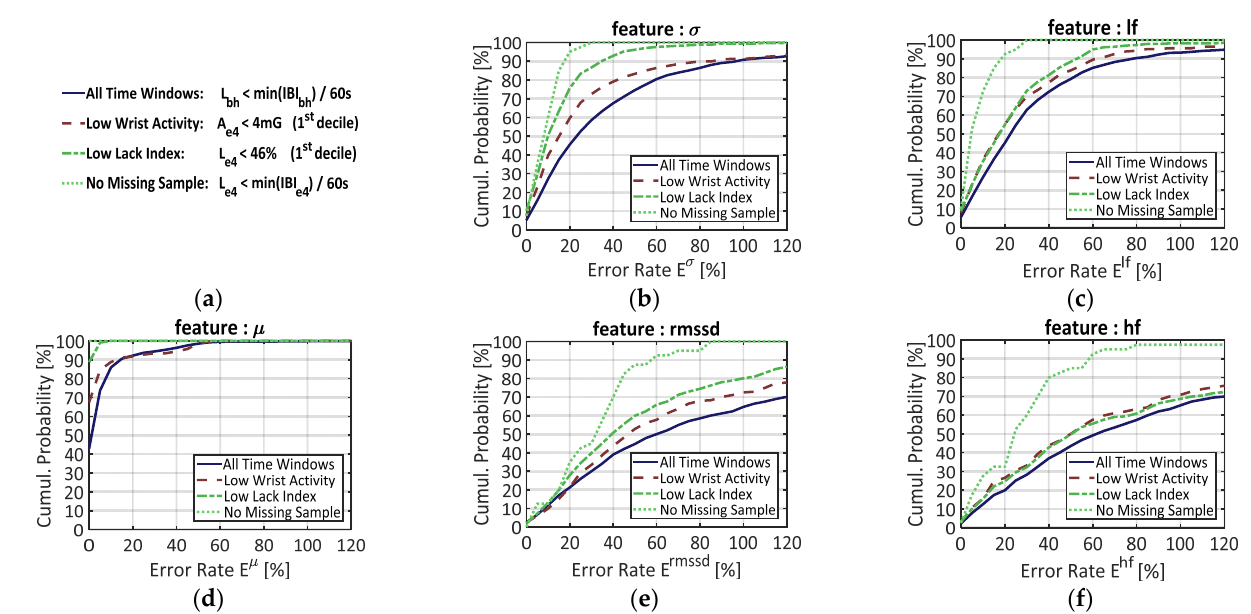
Figure 5. Cumulative probability of error for five features extracted from signal IBI e4 , with signal IBI bh as benchmark. ( a ) Main legend box; ( b ) Error on the standard deviation of the IBI (σ); ( c ) Error on the normalized power in the low-frequency range (lf); ( d ) Error on the mean IBI (µ); ( e ) Error in the root mean square of successive differences in the IBI (rmssd); ( f ) Error on the normalized power in the high-frequency range (lf). Each feature was computed on four different datasets: (i) over all time windows (blue plain line); (ii) over time windows that belong to the 1st decile of wrist activity A e4 (red dashed line); (iii) over time windows that belong to the 1st decile in the proportion of missing samples, estimated by the Lack index L e4 (green dashed-dotted line); (iv) over time windows showing no missing sample according to the Lack Index L e4 (green dotted line).